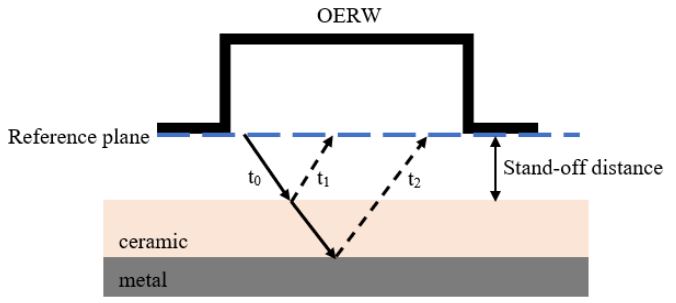
Figure 1. Cross-section of an OERW and the trellis diagram of the incident wave, with its multiple reflections, which are incident wave, t 0 , reflected wave from ceramic and metal surface, t 1 and t 2 , respectively, of a sample under test without delamination.